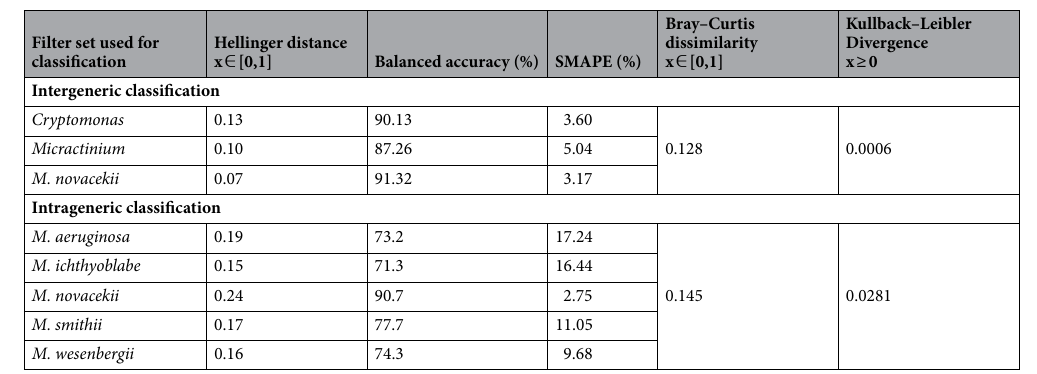
Table 4. Summary of the evaluation of filter sets using balanced accuracy, Hellinger distance and SMAPE, Bray–Curtis dissimilarity, and Kullback–Leibler Divergence.